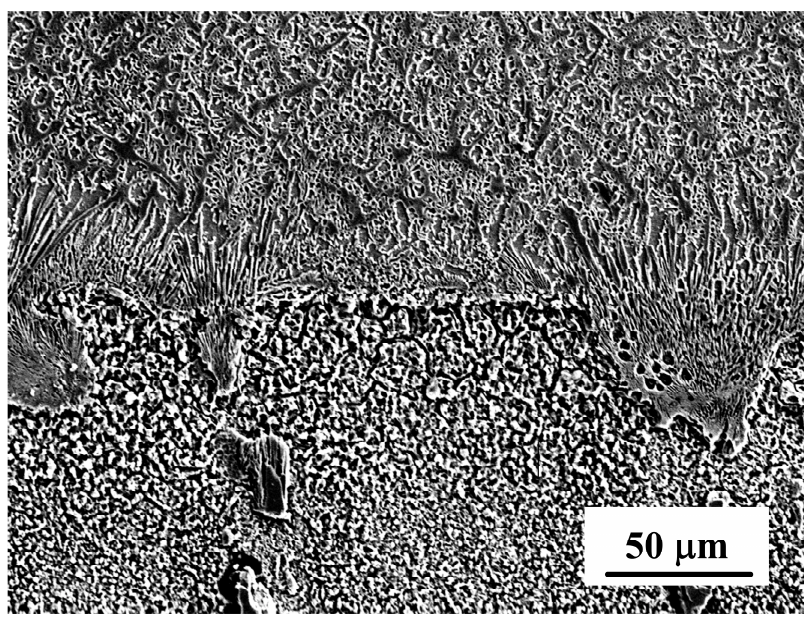
Figure 10. The microstructure of the binding